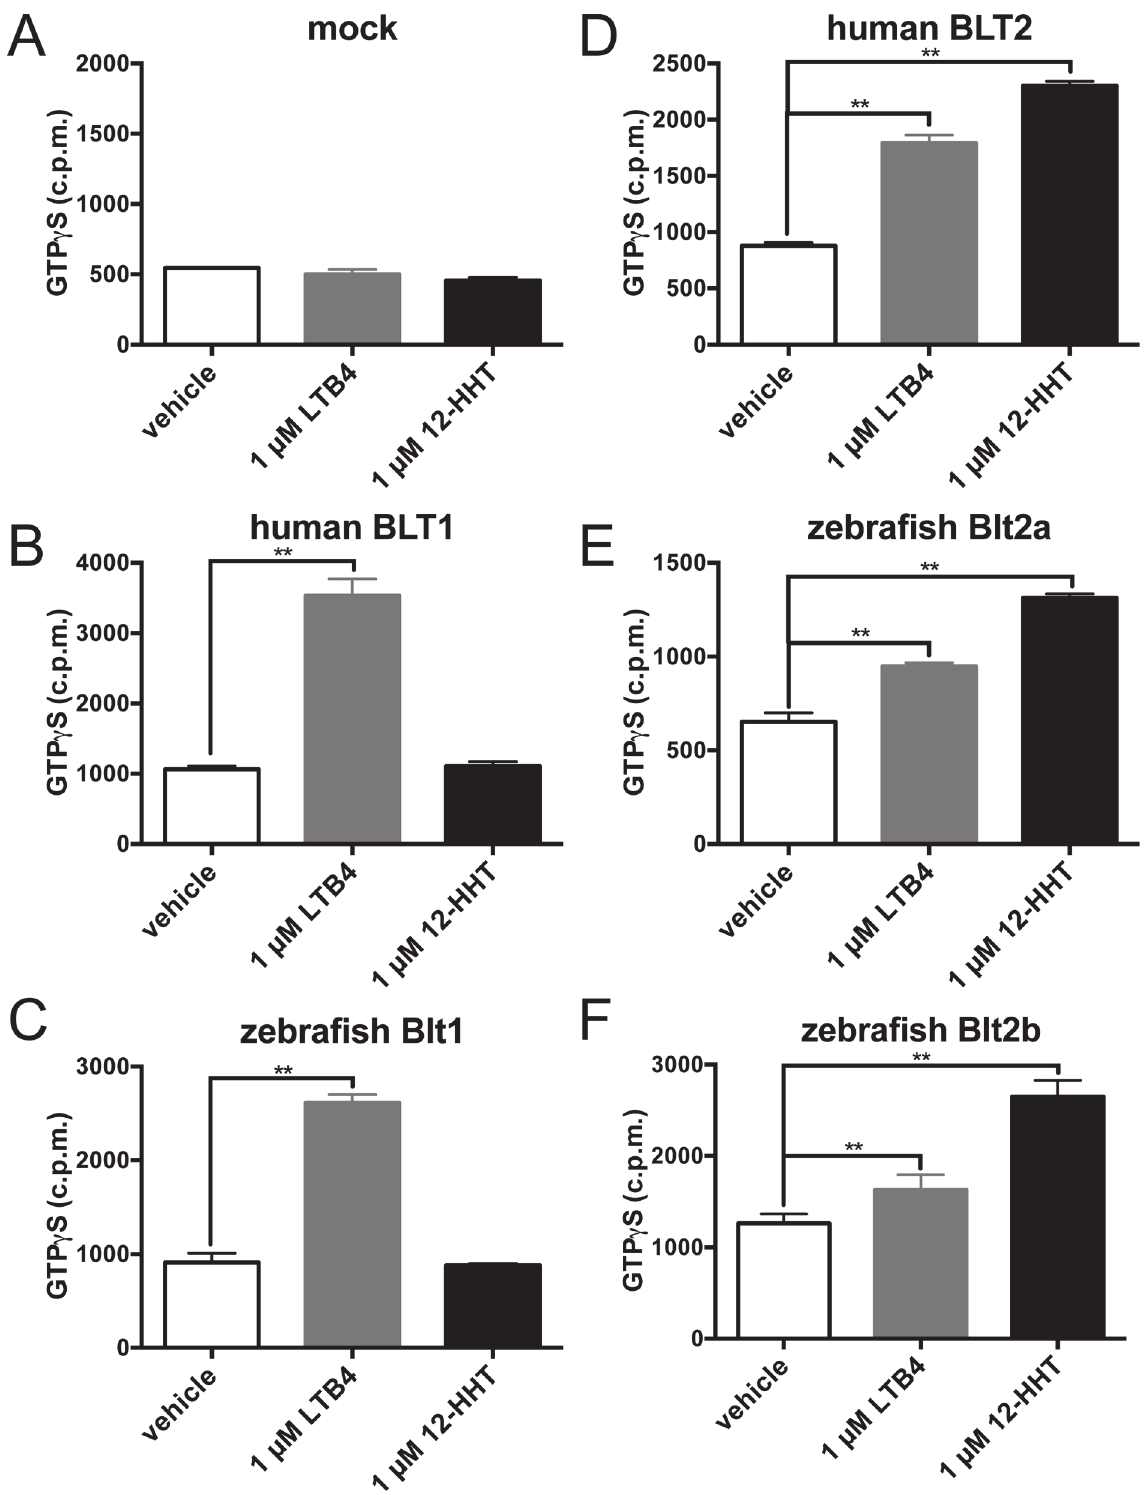
Fig 7. G-protein activity in CHO cells expressing the zebrafish Blt receptors. Membrane preparations of CHO cells expressing human or zebrafish receptors were incubated with 1 nM [ 35 S] GTP γ S and 1 μ M LTB 4 or 12-HHT, and specific binding was measured. Data represent the mean ± s.e.m. (n = 3). ** , P < 0.005, one-way ANOVA with Bonferroni post-hoc test. These data are representative of at least two independent experiments with similar results.